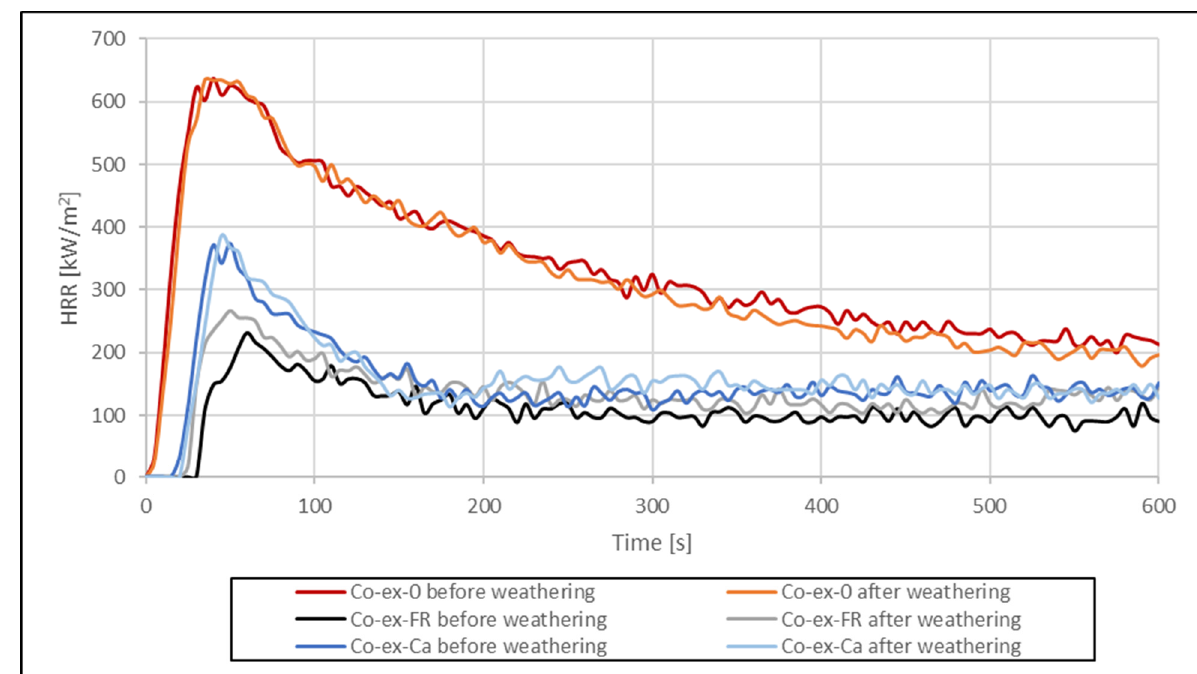
Figure 19. Change in time to ignition, peak heat release rate, and total heat release after 600s in extruded profiles with fire-retardant (FR CROS 490) or calcium carbonate (Ca) or without any filler (0), after artificial weathering for 28 days. FR CROS 490 or Ca were added either in the co-extruded layer or in the bulk of the profiles.